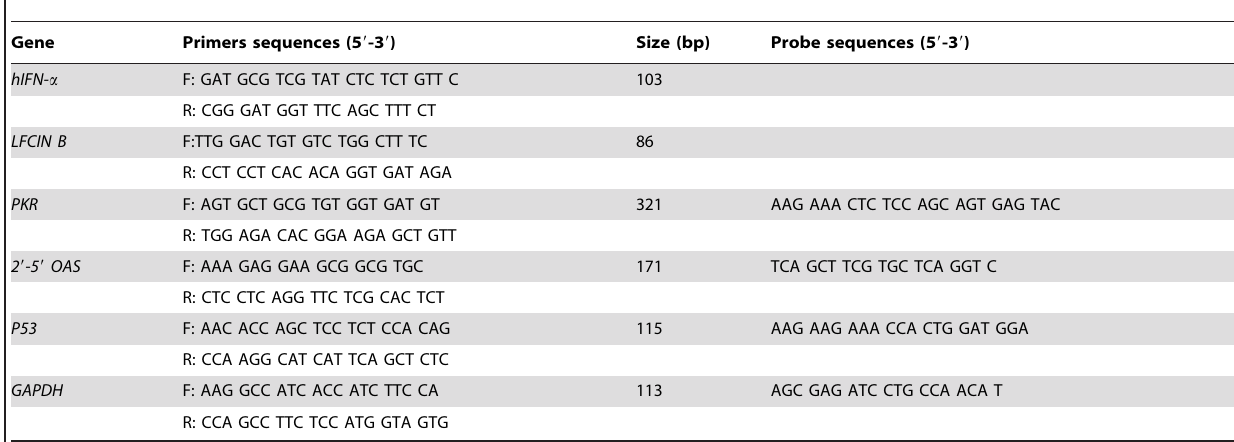
Table 1. Primer and probe